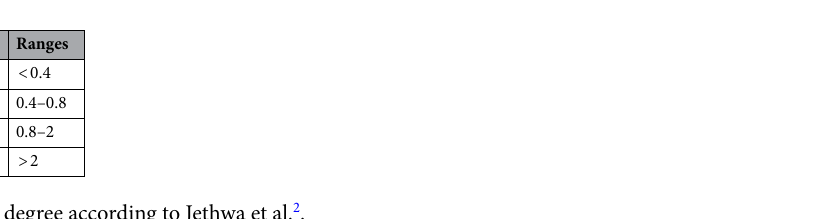
Table 2. Squeeing degree according to Jethwa et al. 2